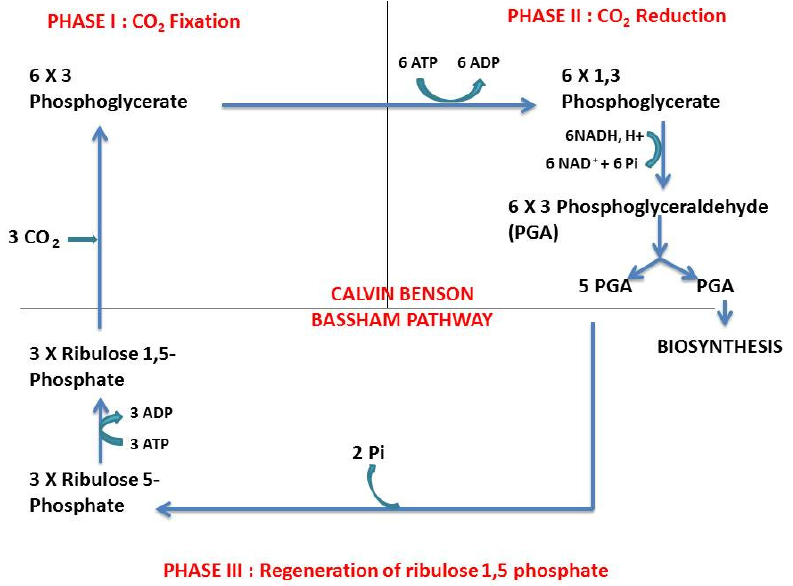
Fig. 1: The Calvin-Benson-Bassham cycle used by Chemolithotrophs (Bertrand, 2015)